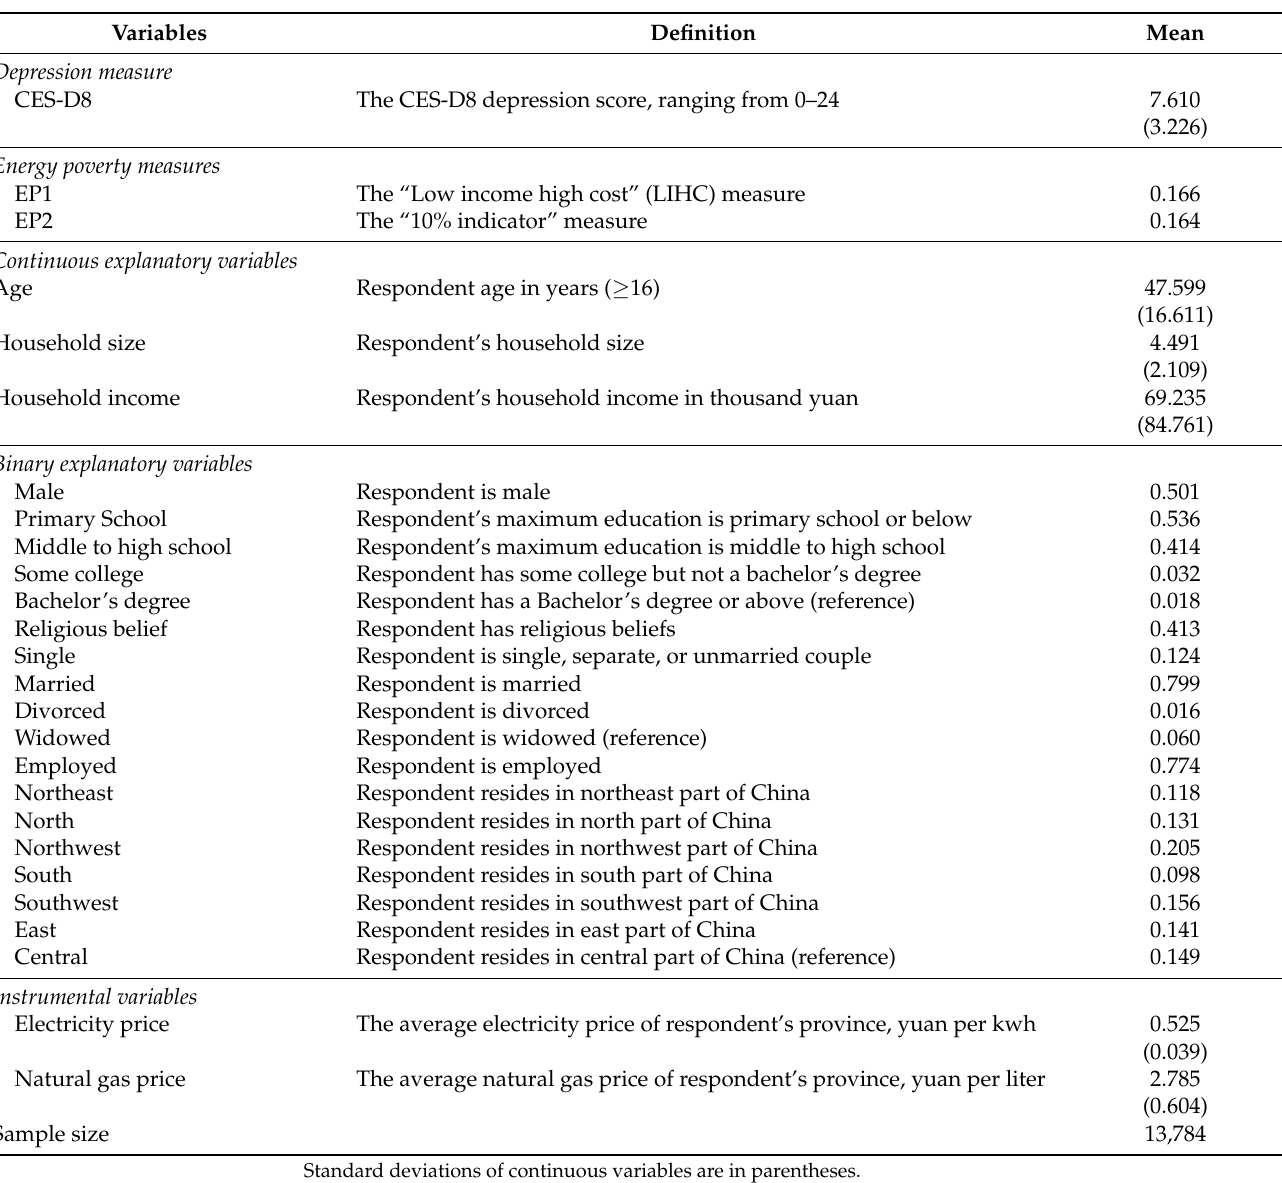
Table 1. Variable Definitions and Sample